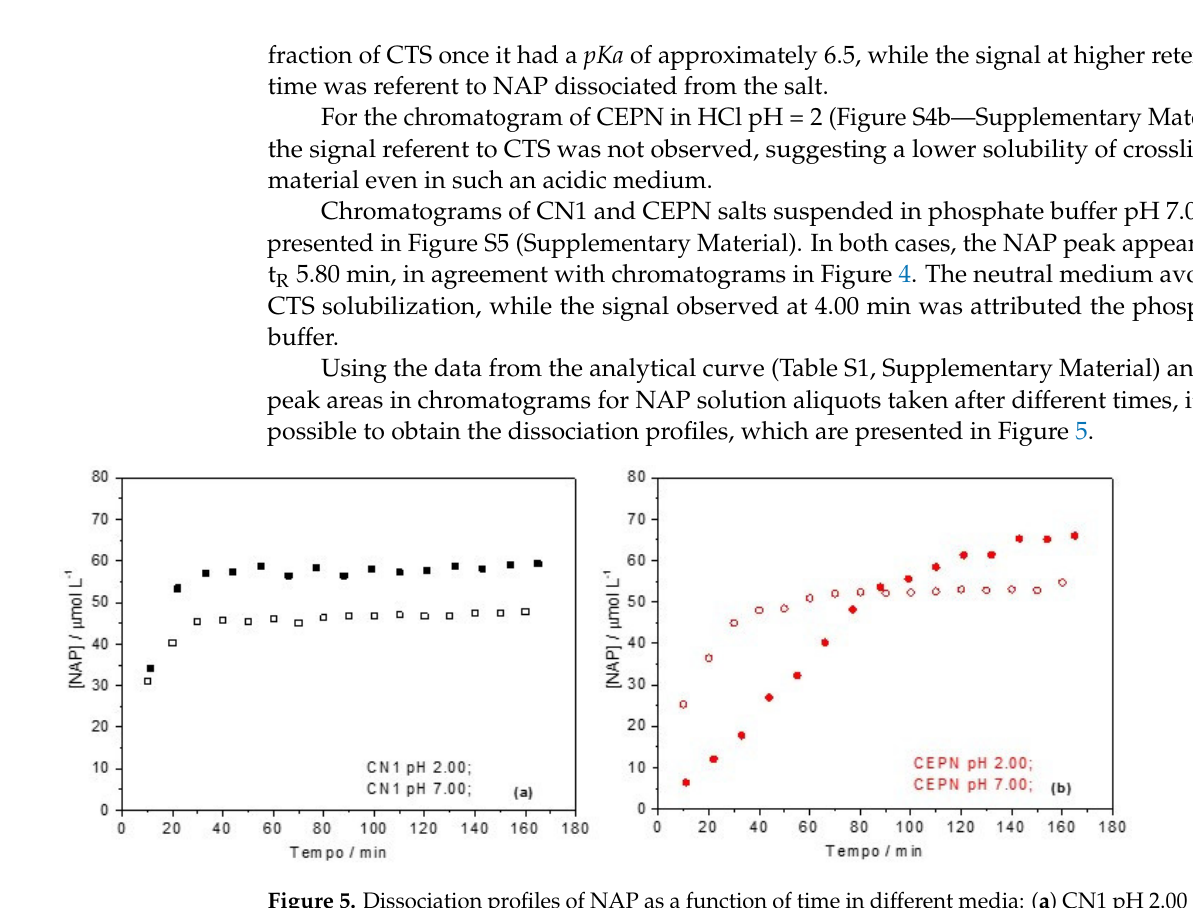
Figure 5. Dissociation profiles of NAP as a function of time in different media: ( a ) CN1 pH 2.00 (filled black) and 7.00 (leaked black); ( b ) CEPN pH 2.00 (filled red) and pH 7.00 (leaked red).